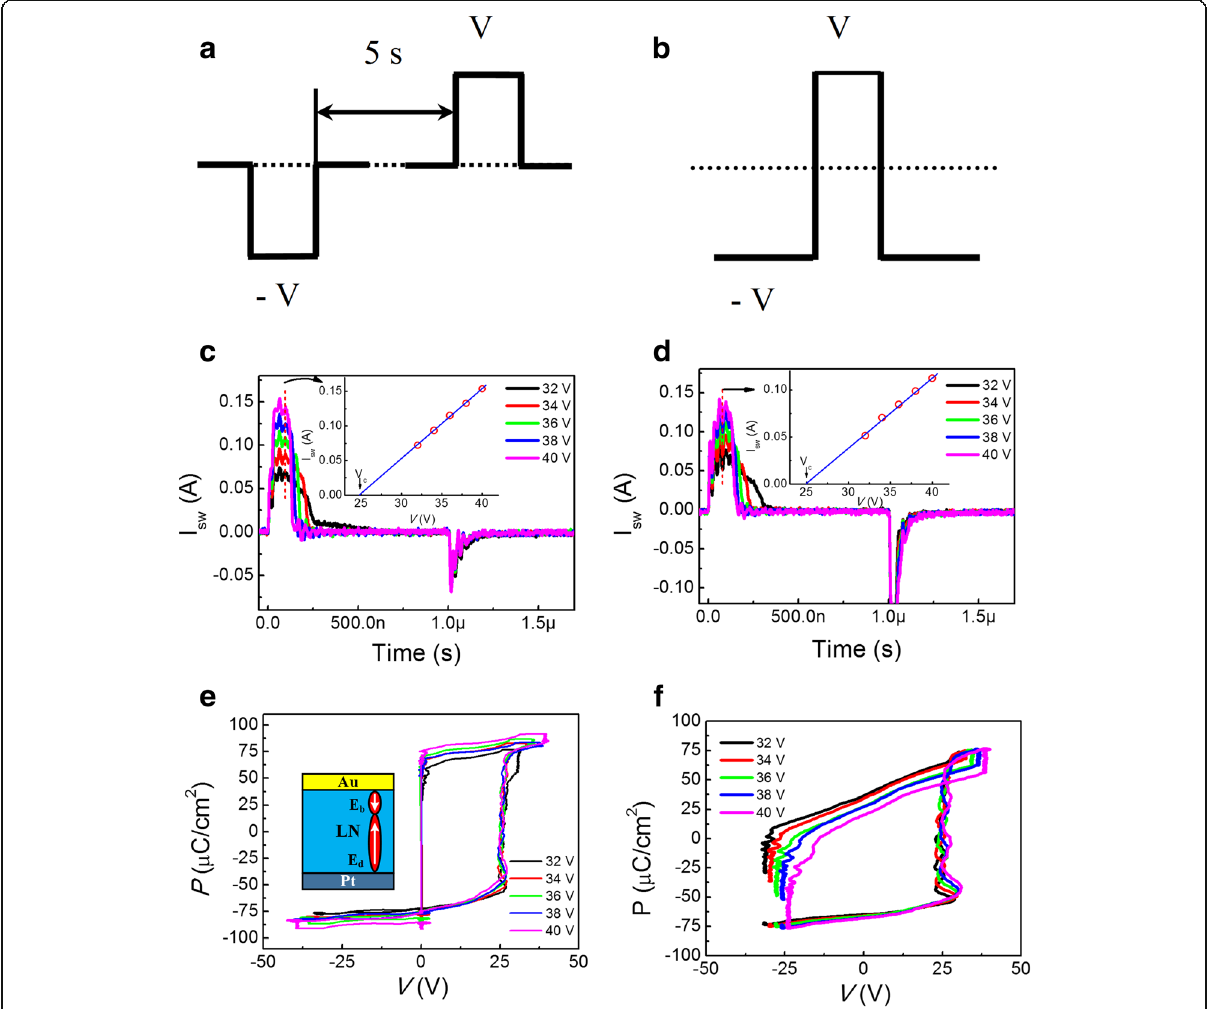
switching pulse overlapping a negative DC bias). Domain switching current transients under different V applied to a virgin sample in c type I and d type II modes, where the insets show the linear fit of the dependence of the plateaus of domain switching current on V . P - V hysteresis loops under different V transferred from domain switching current transients in e type I and f type II. Schematic diagram of the Au/LN/Pt structure and the directions of the built-in electric field E b and depolarization field E d in the inset of